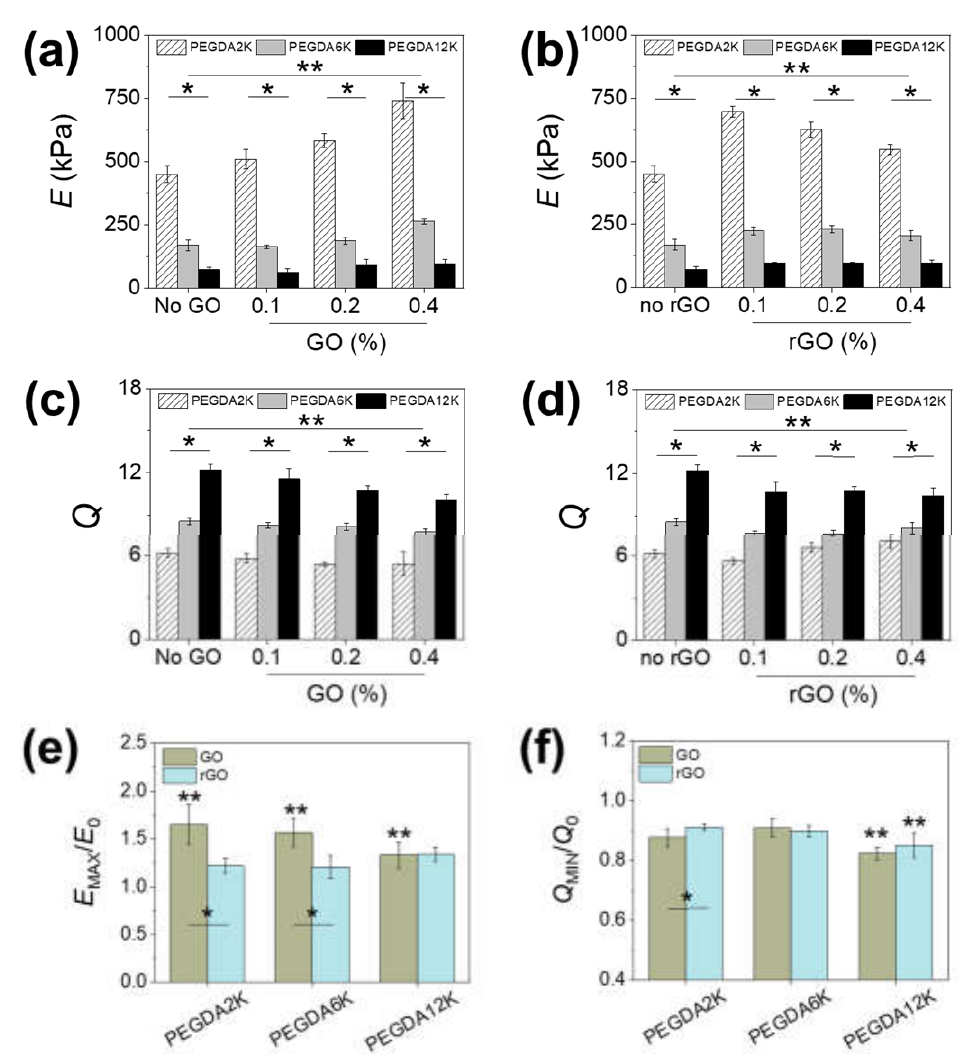
Figure 2. ( a , b ) Elastic moduli ( E ) and ( c , d ) swelling ratios ( Q ) of PEG-PNIPAm hydrogels with varying concentrations of ( a , c ) GO or ( b , d ) rGO (* p < 0.01 compared between different M W of PEGDA at the same graphene concentration, ** p < 0.05 compared between different graphene concentrations at the same M W of PEGDA, n = 10). The concentration of PEGDA was 10%. ( e , f ) The ratios of the maximum E ( E MAX ) and minimum Q ( Q MIN ) by GO or rGO to the E and Q of pure PEGDA ( E 0 , Q 0 ) (* p < 0.05 compared between GO and rGO at the same M W of PEGDA, ** p < 0.05 compared between different M W of PEGDA, n = 10).